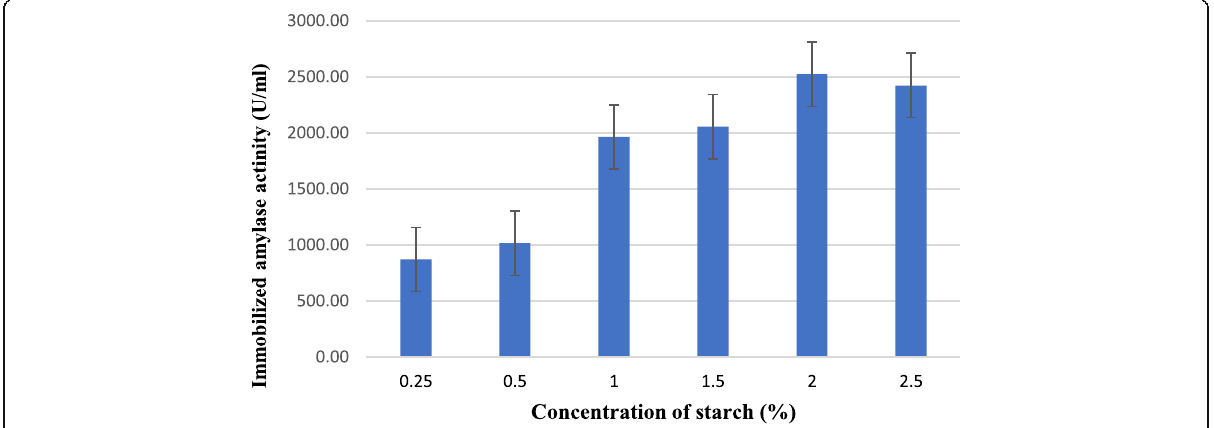
Fig. 6 Effect of concentration of substrate on the activity of immobilized amylase